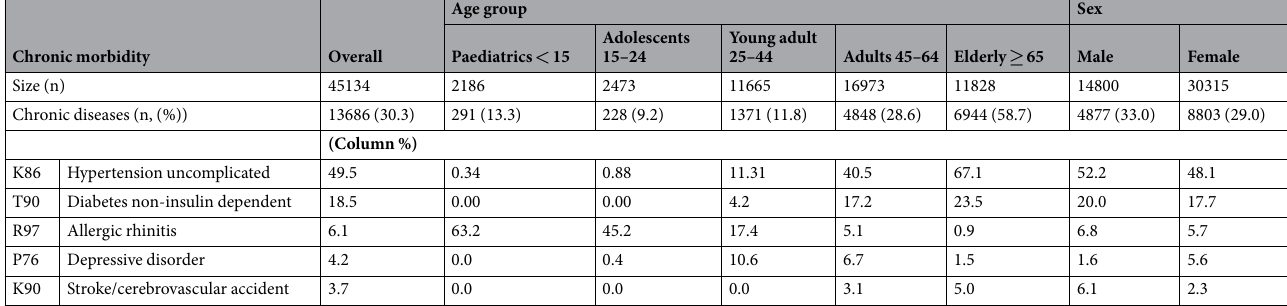
Table 4. Co-morbidities of the five most common chronic conditions based on ICPC-2 coding, separated by age group and sex.